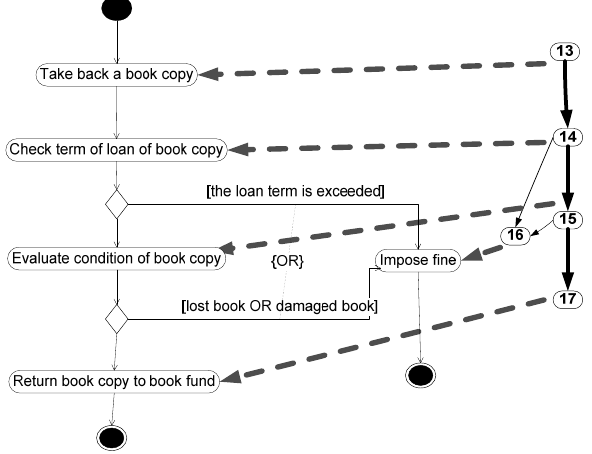
Fig. 3. Use cases “Return book” and “Impose fine” in modified UML activity